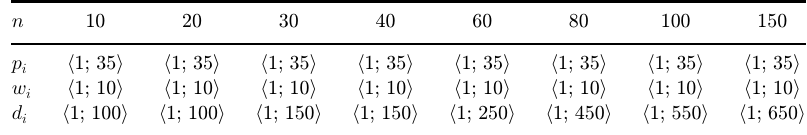
Table 1. Parameters of inputs in